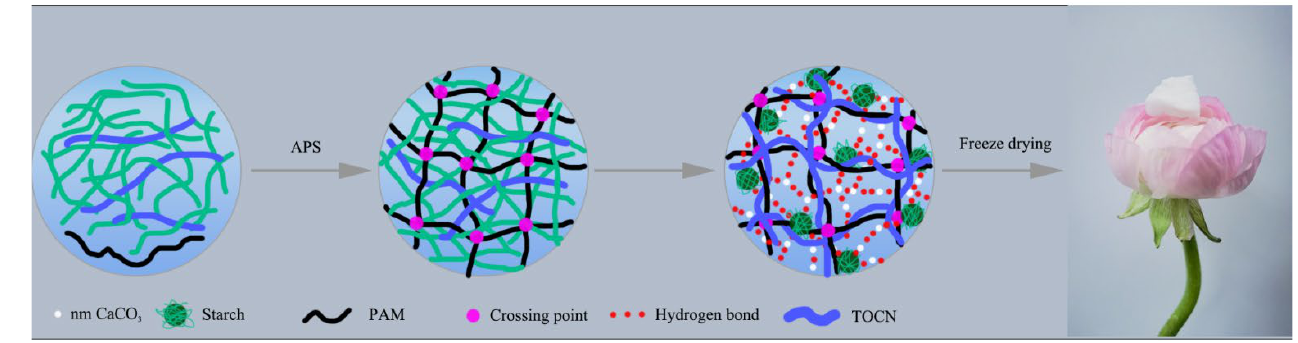
Scheme 1. Schematic illustration of the preparation of CaCO 3 @STA/PAM/TOCN aerogel.